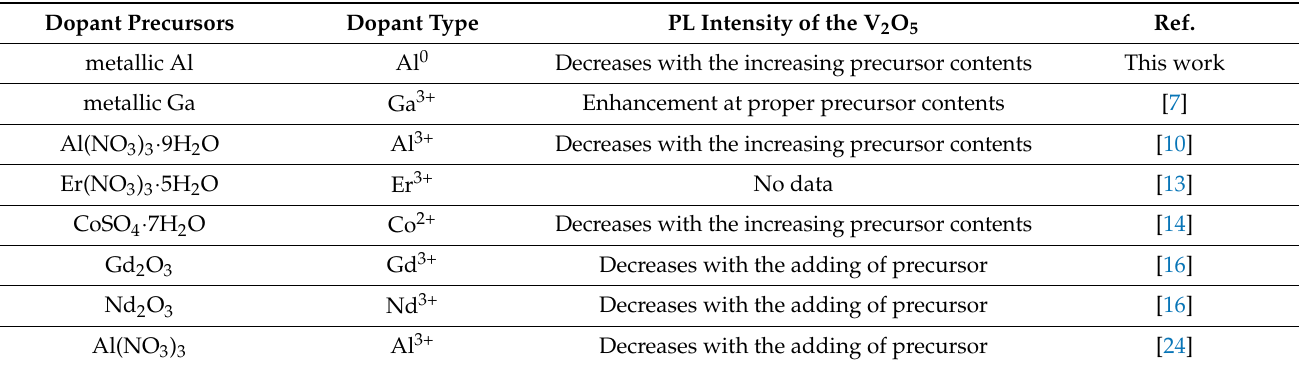
Table 4. The influence in PL intensities of V 2 O 5 in various dopant